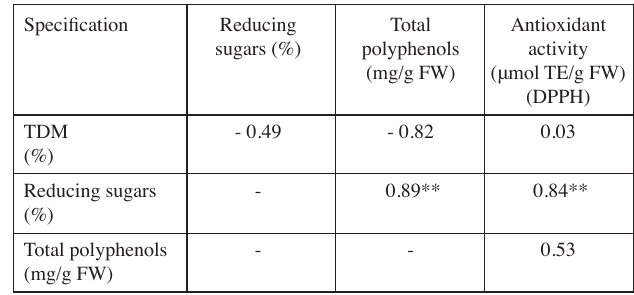
Tab. 4: Correlation coefficients (r) between chemical compounds analyzed in sweet potato